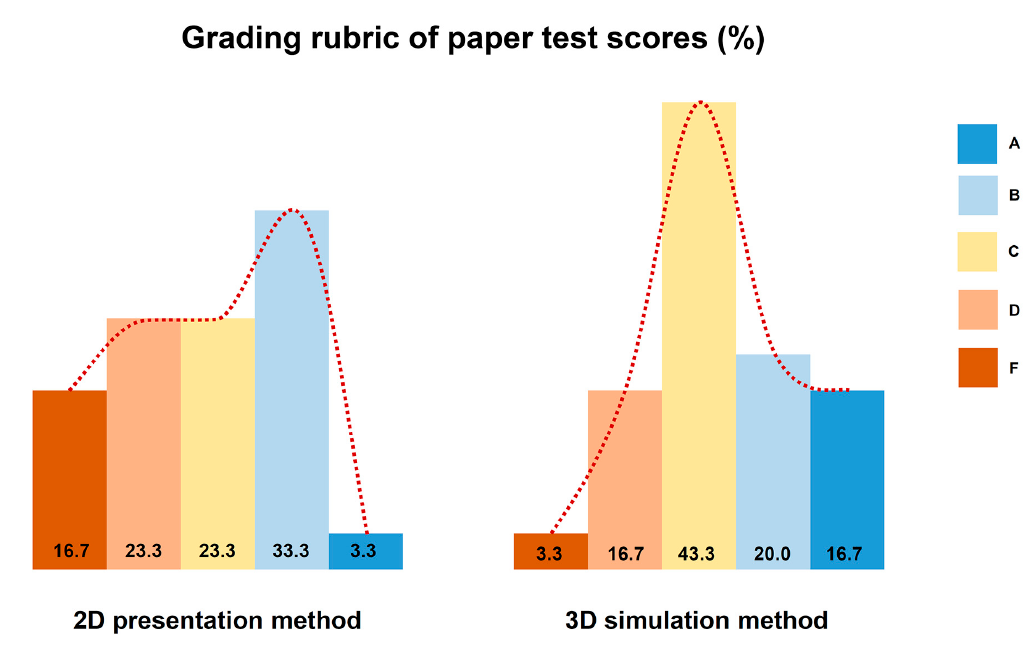
Figure 5. Grading of examination scores.